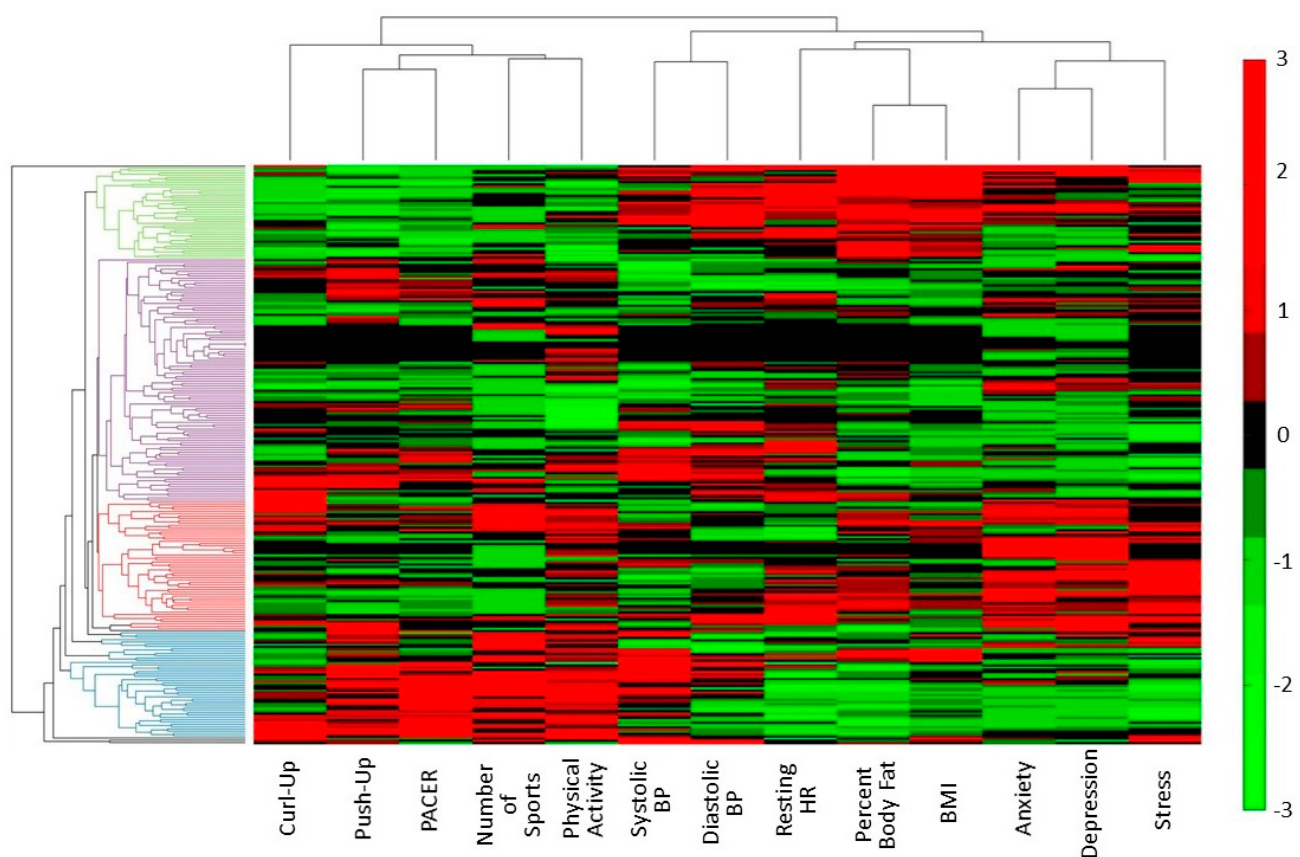
Figure 2. Clustergram of the population across the 13 variables of interest. The x-axis represents each of the 13 variables of interest and their clustering based on similar response profiles across participants. The y-axis represents each participant and their clustering based on similar profiles across all 13 variables (i.e., shortest Euclidian distance across all variables). The red-green color coding represents the normalized scores for each variable, where red represents high scores for a particular variable, black represents average scores, and green represents low scores.